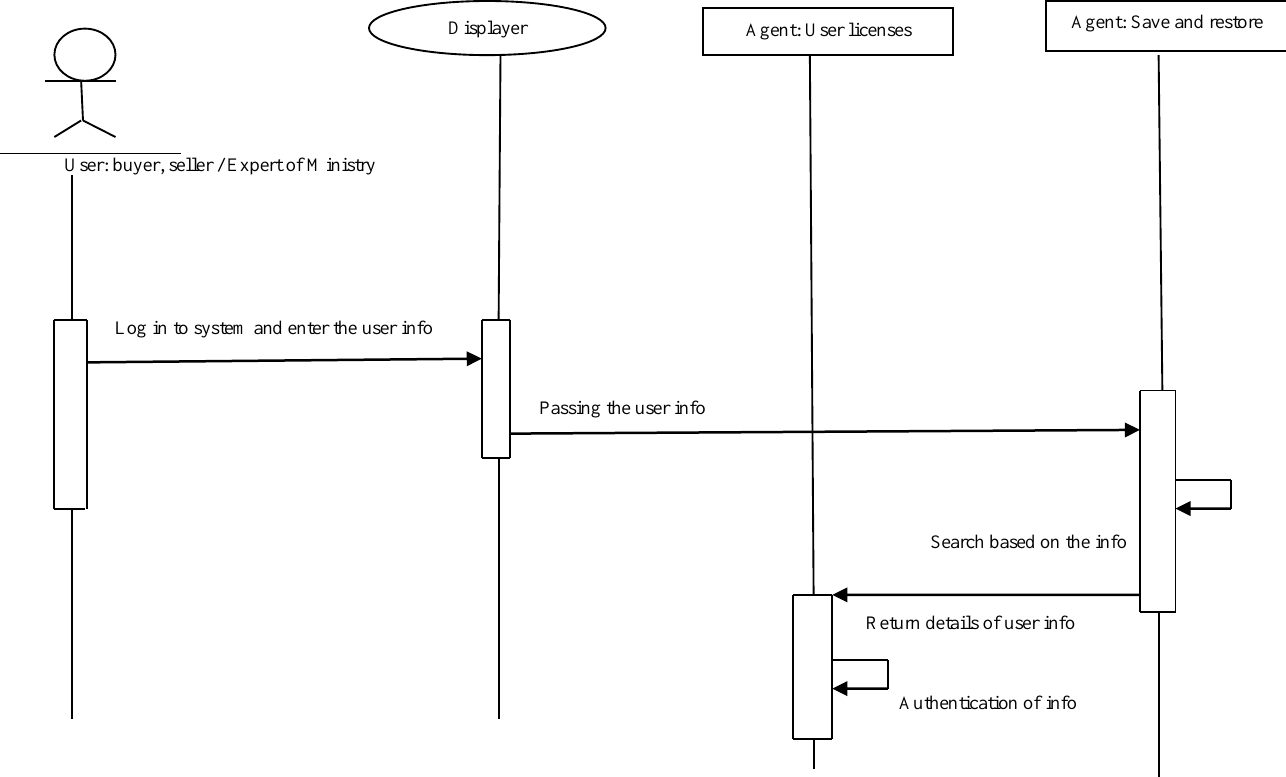
Figure 8. Interaction model of user licenses role within the scope of authentication.